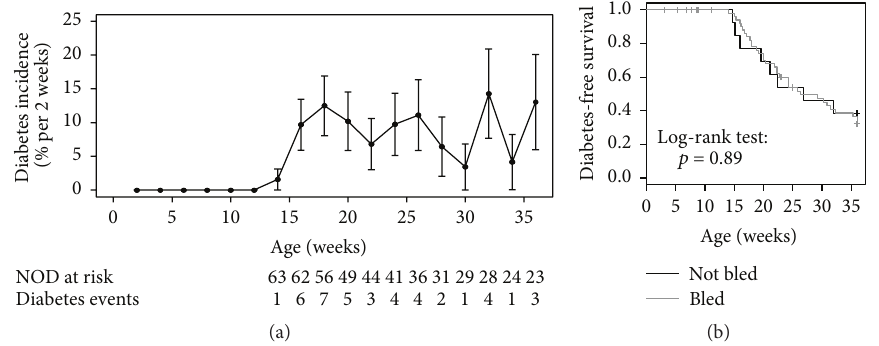
Figure 1: Diabetes development shown (a) as an incidence in all NOD mice followed up in the study and (b) as diabetes-free survival comparing NOD mice that were bled biweekly (black line) and NOD mice that were followed up without blood draws (gray line; 𝑝 = 0.89 ).